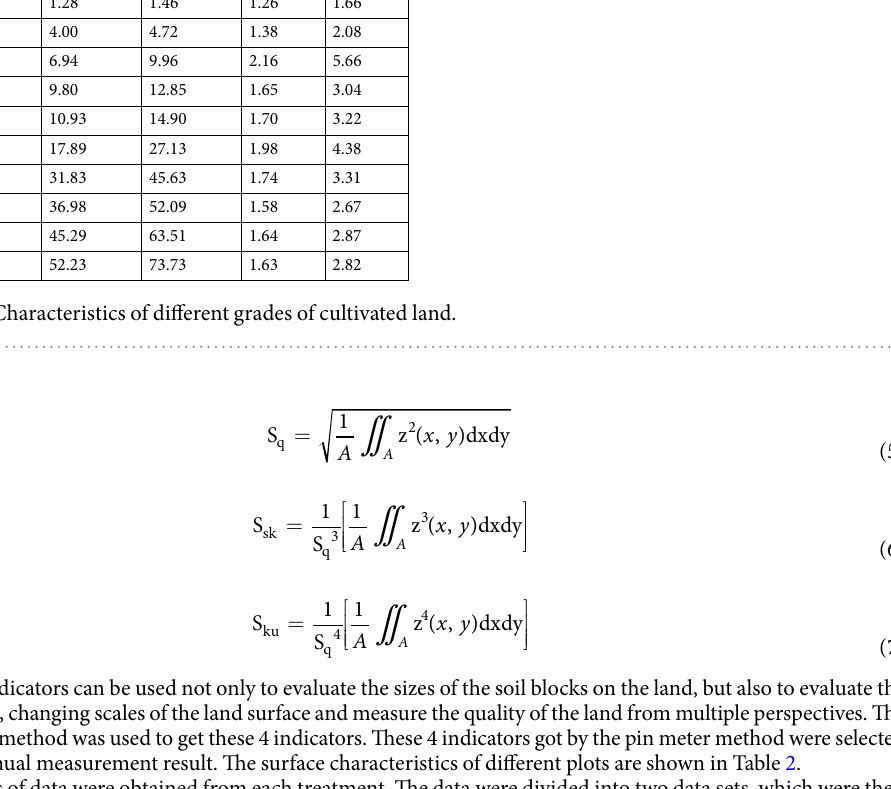
values of Sa were 0.97 ** (Calibration) and 0.97 ** (Validation), and the RMSE were 3.09 (Calibration) and 3.46 (Validation). The correlation coefficient (R 2 ) of the 2 values of Sq were 0.98 ** (Calibration) and 0.98 ** (Validation), and the RMSE were 3.92 (Calibration) and 4.35 (Validation). The above results indicate that the characterisitic values measured by Kinect are accurate, providing a basis for the later grade classification of cultivated land.